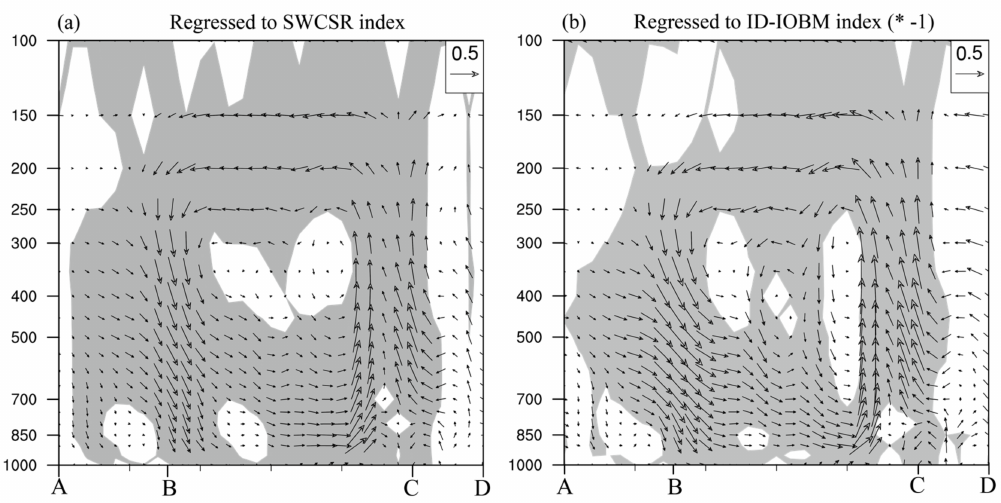
Figure 6. Regressed vertical circulation against ( a ) the SWCSR index and ( b ) the ID-IOBM index along line ABCD (m/s, vertical speeds are multiplied by 50 for visual clarity). “*” denotes “multiply by”. Shading indicates the areas significant at the 90% confidence